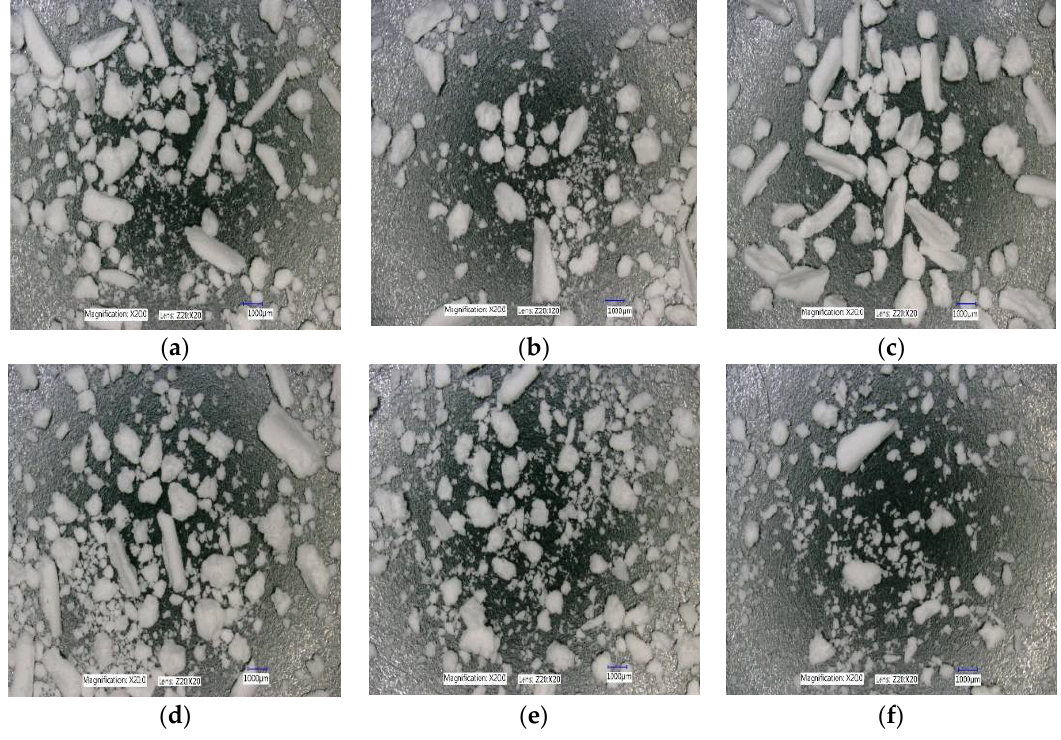
Figure 20. Microscopic images of MCC granules produced at varying screw speed at SFL—0.166 and